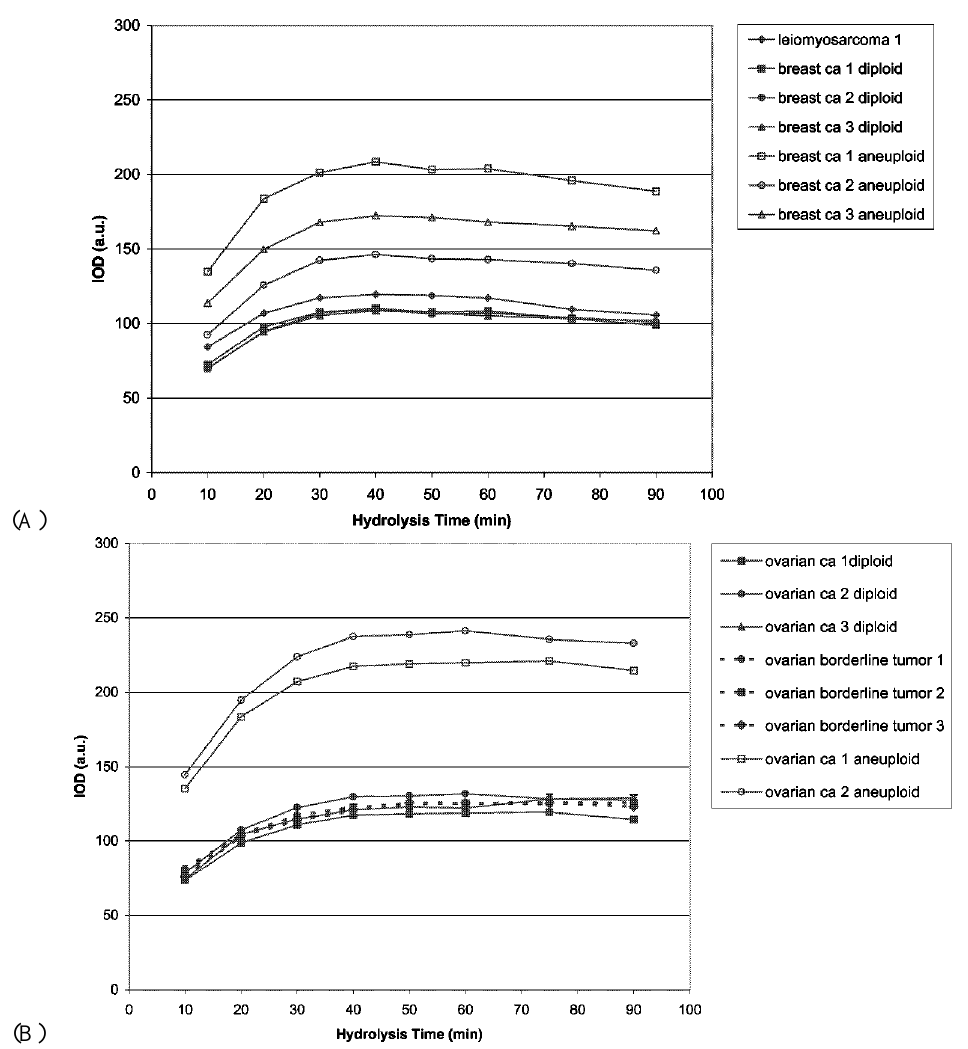
Fig. 1. (A) Hydrolysis profiles of diploid and aneuploid cell populations in breast carcinoma, and of diploid cell population in leiomyosarcoma based on IOD (integrated optical density). (B) Hydrolysis profiles of diploid and aneuploid tumor populations in ovarian serous carcinoma and of diploid cell populations in ovarian serous tumor of borderline malignancy based on IOD. ment, were tested with ANOVA (Tukey Studentized rang test). The differences were considered statistically significant at p < 0 :